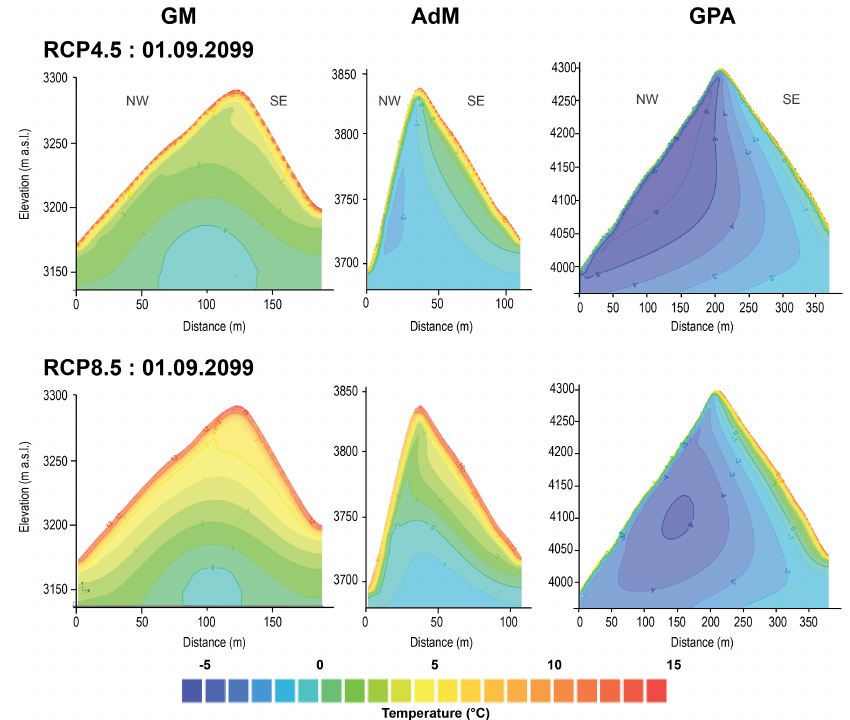
Figure 8. Time-dependent conditions in September 2099 after RCP4.5 and 8.5 forcings for the three investigated sites.